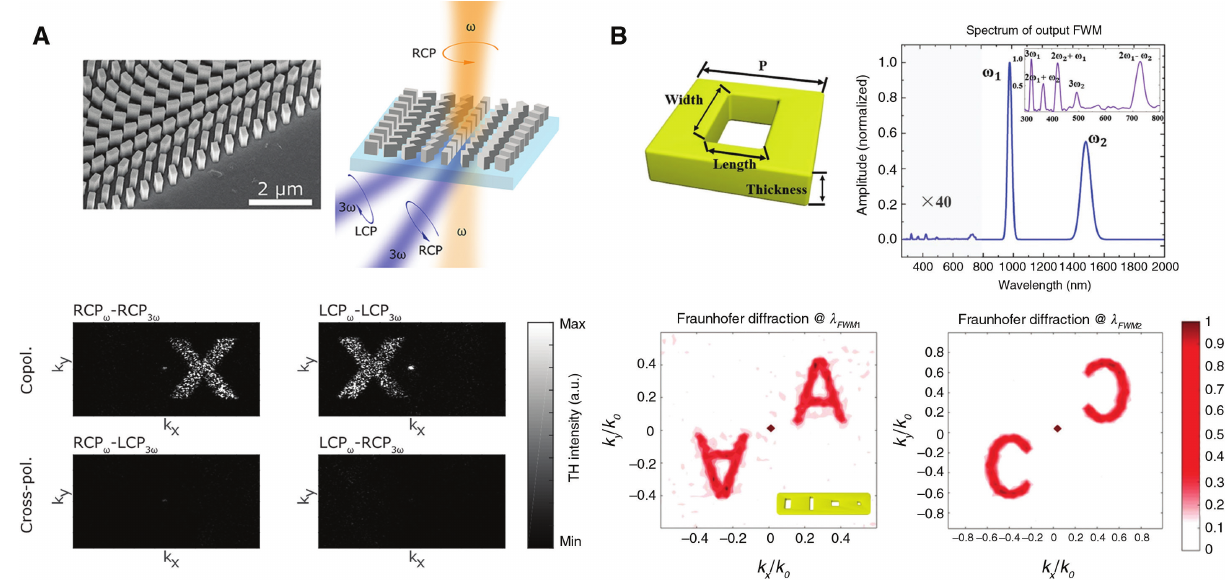
Figure 5: Nonlinear metasurfaces. (A) Scanning electron microscopy image of the geometric phase nonlinear silicon metasurface and its measured holographic reconstructed images for different combinations of the input and output polarizations [118]. (B) Schematic illustration and simulation results of the four- wave mixing nonlinear holography based on a gold nanoaperture metasurface